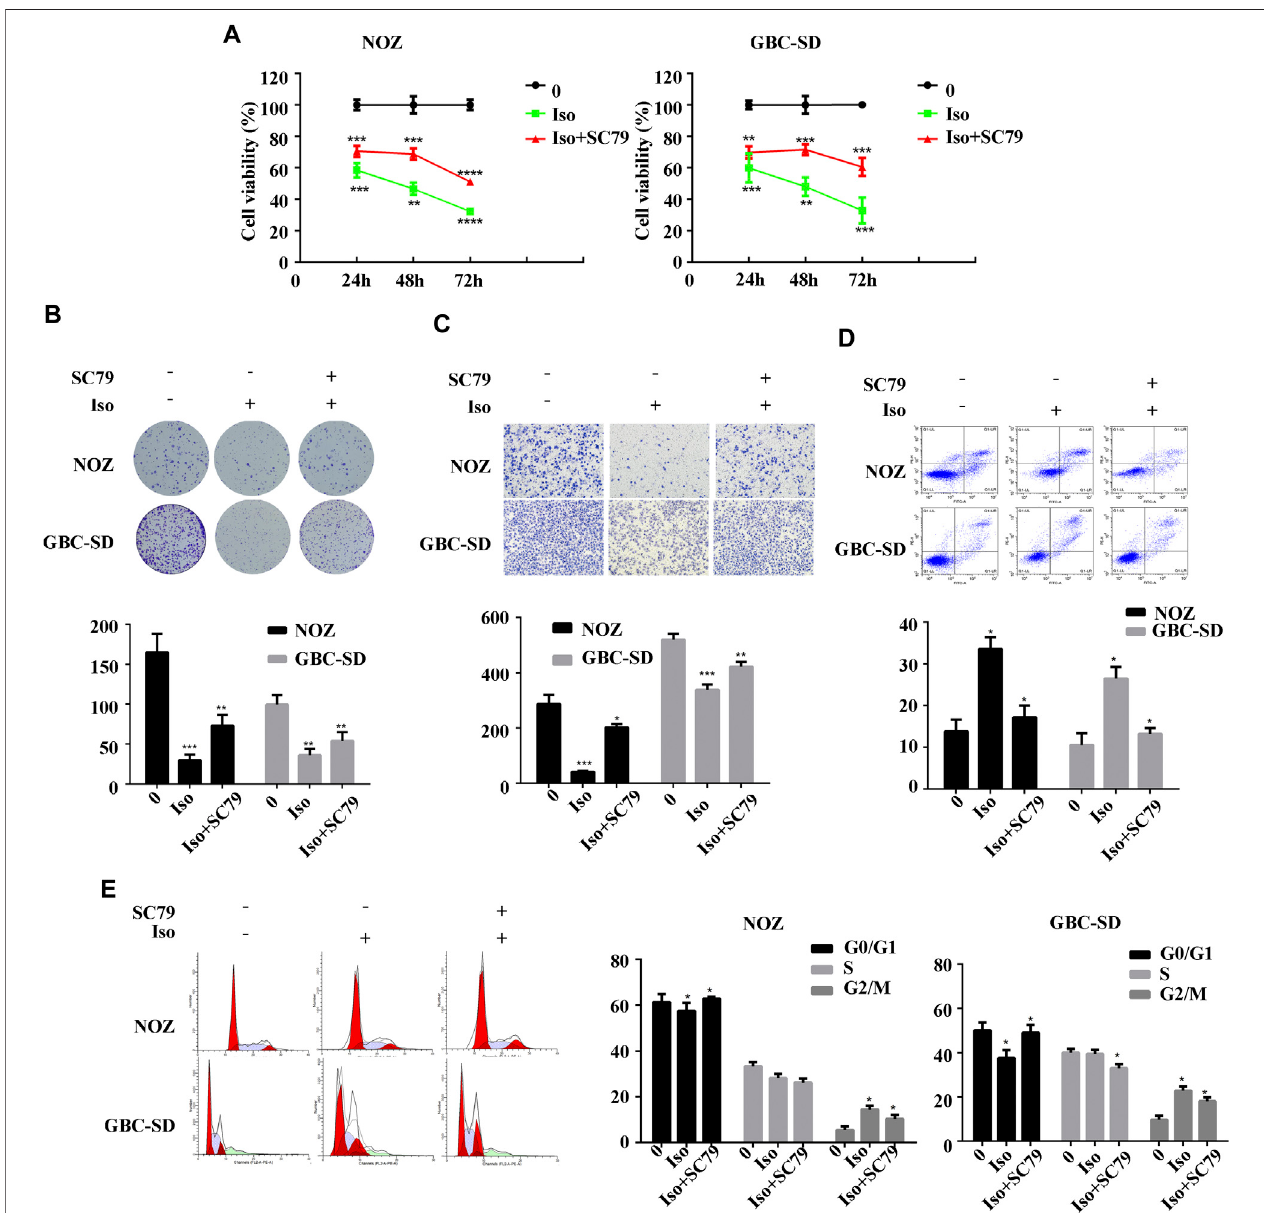
FIGURE 5 | Isorhamnetin inhibits GBC cell proliferation and metastasis via the PI3K/AKT pathway. (A) The cell viability of GBC cells assessed using CCK-8 assay after isorhamnetin treatment (0 and 80 μ M) with or without SC79 pretreatment for 1 h. (B) Colony formation assay of NOZ and GBC-SD cells for 10 days. (C) Cell migration, (D) apoptosis, and (E) cell cycle were detected. * p < 0.05, ** p < 0.01, *** p < 0.001 relative to the control